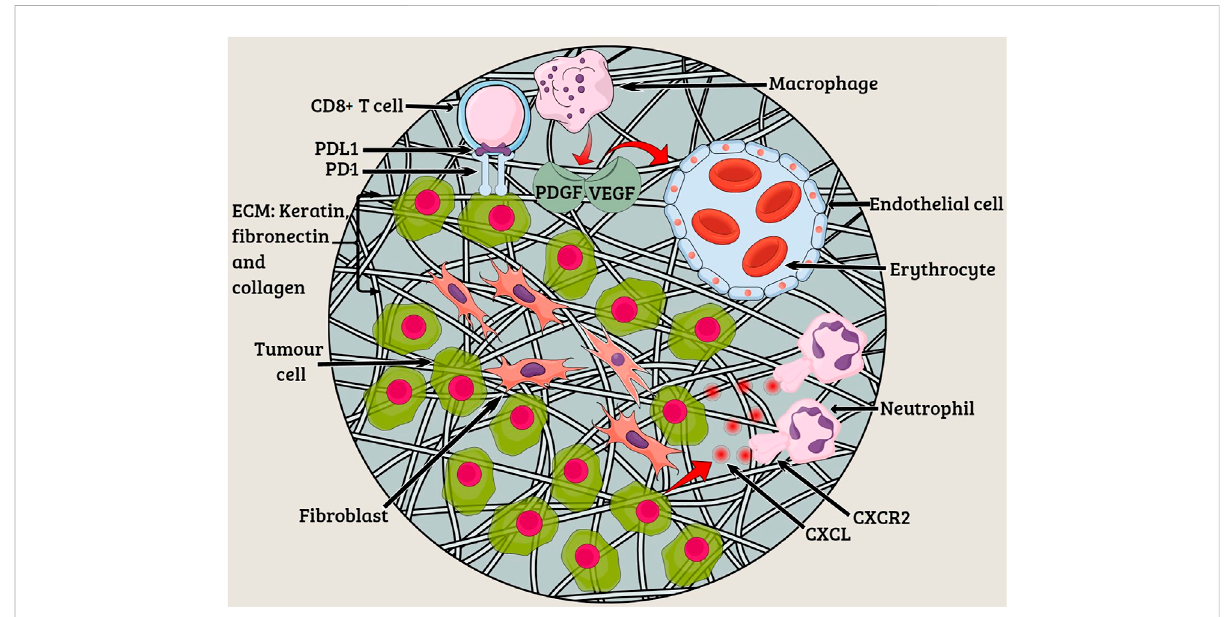
FIGURE 1 Tumormicroenvironment.Thecharacteristicsoflungtumorsareoftendeterminedby fi broblasts,endothelialcells,andmyeloidcellsexistinginthe tumor microenvironment. Extracellular matrix (ECM) constituting keratin, fi bronectin, and collagen functions to provide structural support to tumor cells.Angiogenesisoccursduetothepresenceofplatelet-derivedgrowthfactor(PDGF)andvascularendothelialgrowthfactor(VEGF)atthetumorsite. The CXC-chemokine ligand (CXCL) family members bind to the neutrophil receptor CXCR2 to help the tumor cells recruit